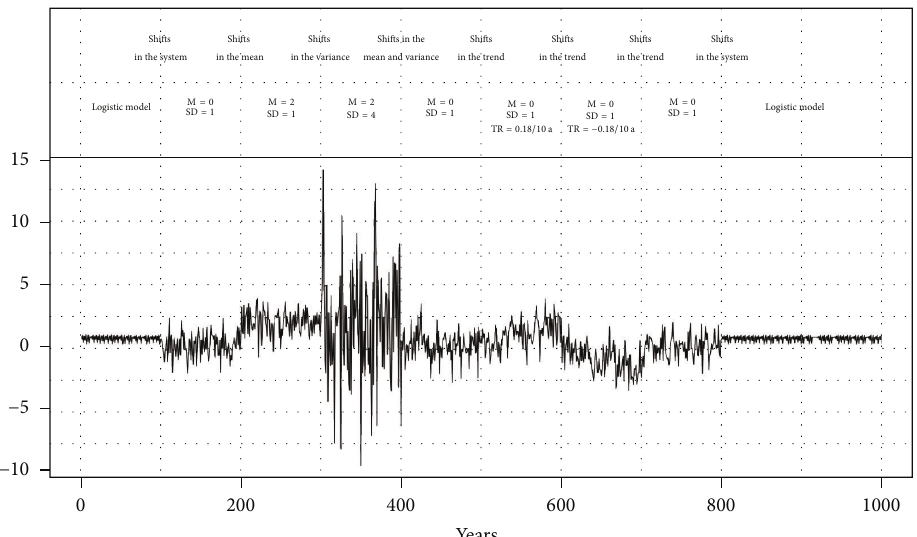
Figure 1: Time series with different abrupt characteristics generated